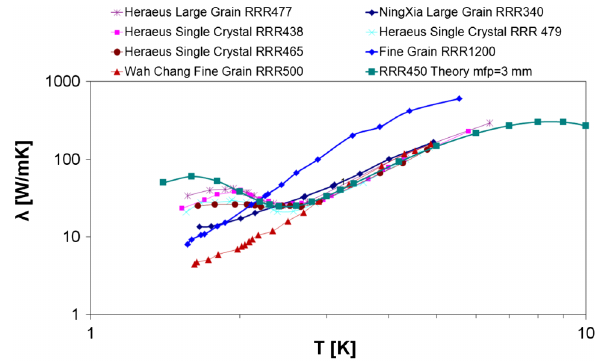
single crystal niobium (mfp: phonon mean-free path).